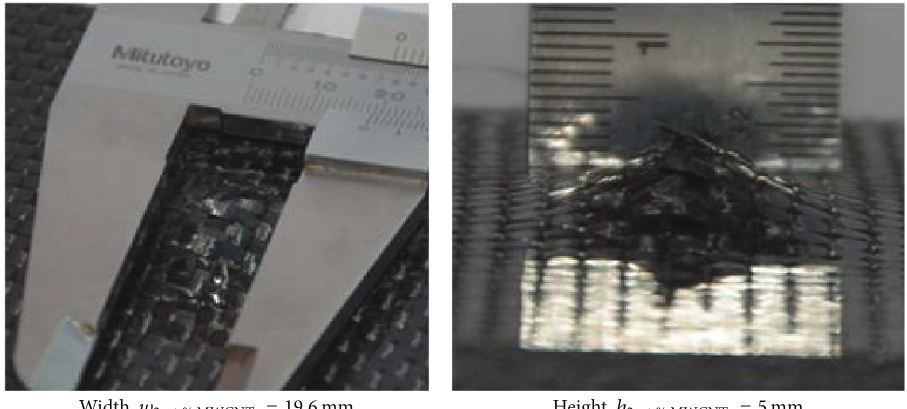
Width, w 2wt.%MWCNTs = 19.6 mm Figure 8: Pyramidal damage of asymmetric CFRP with 2 wt.% MWCNTs mixed in epoxy.